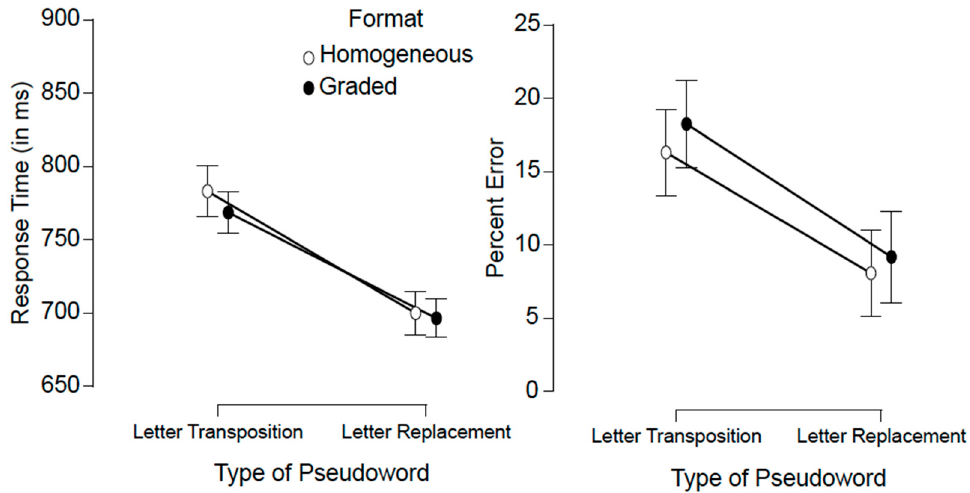
Figure 2. Mean RTs and error rates in each of the conditions of the experiment for the pseudowords. The bars represent the standard errors.